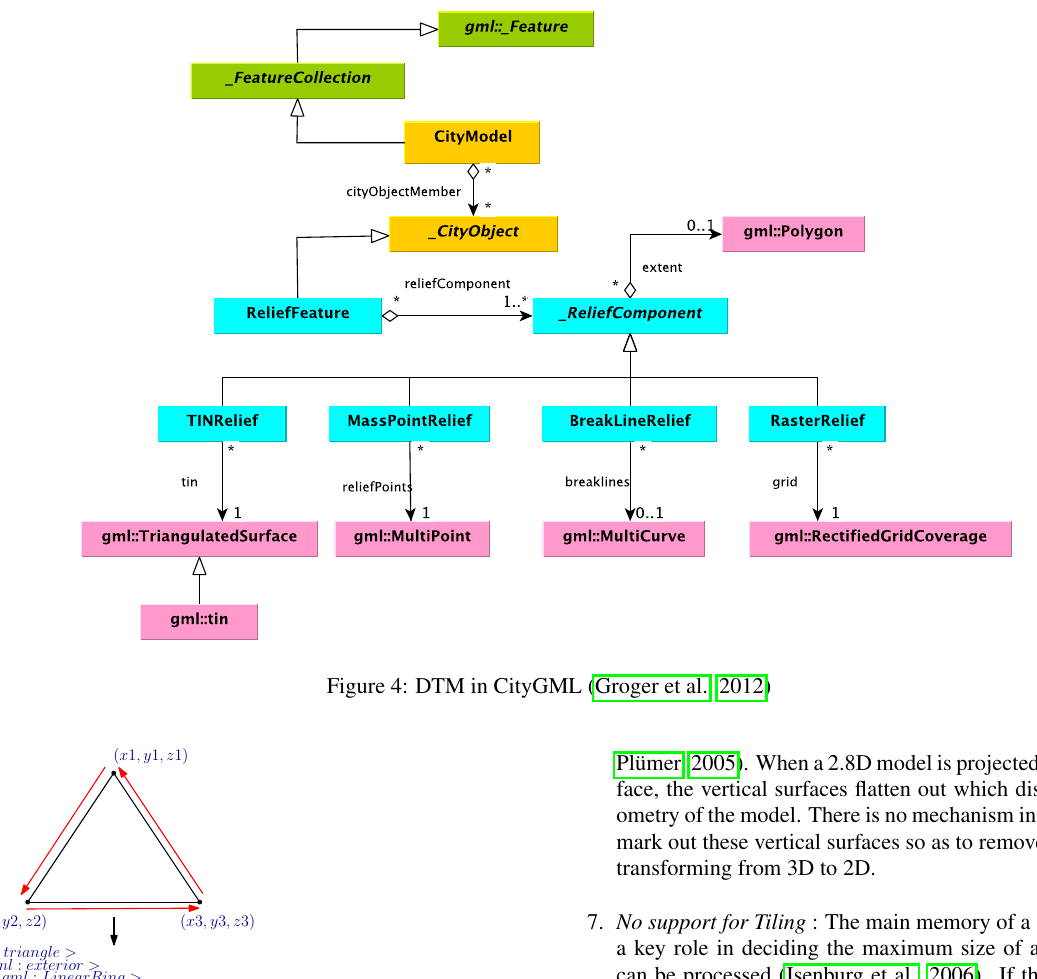
Figure 4: DTM in CityGML (Groger et al., 2012)